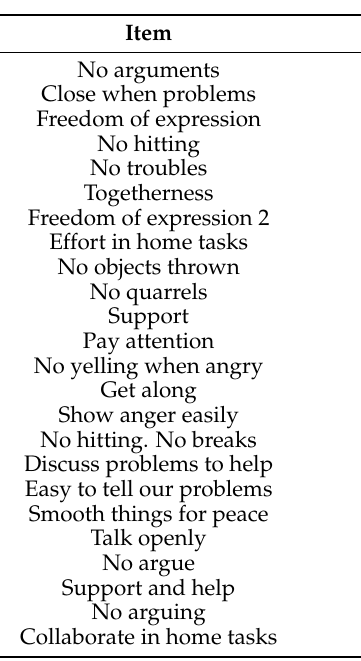
Table 4. TFN and crisp values. Total